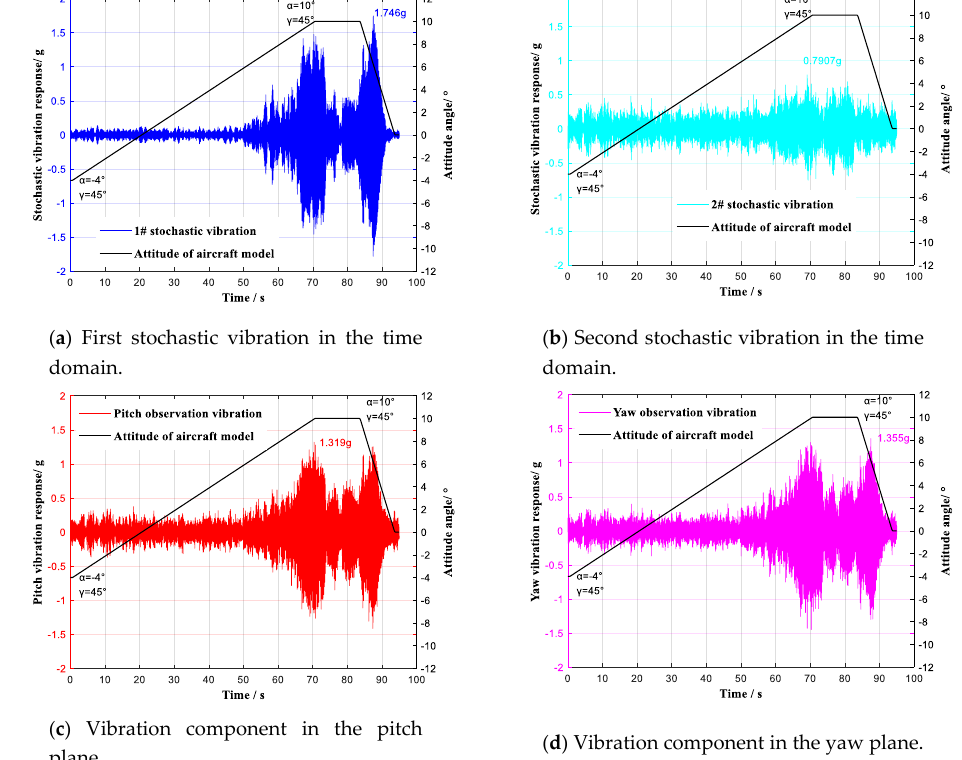
Figure 12. Vibration monitoring with continuous lifting (γ = 0°) of the aircraft model at Ma = 0.6. A comparison of the vibration characteristics of the two selected stochastic vibrations, i.e., the vibration component in the pitch plane and the vibration component in the yaw plane, is shown in Figure 13.